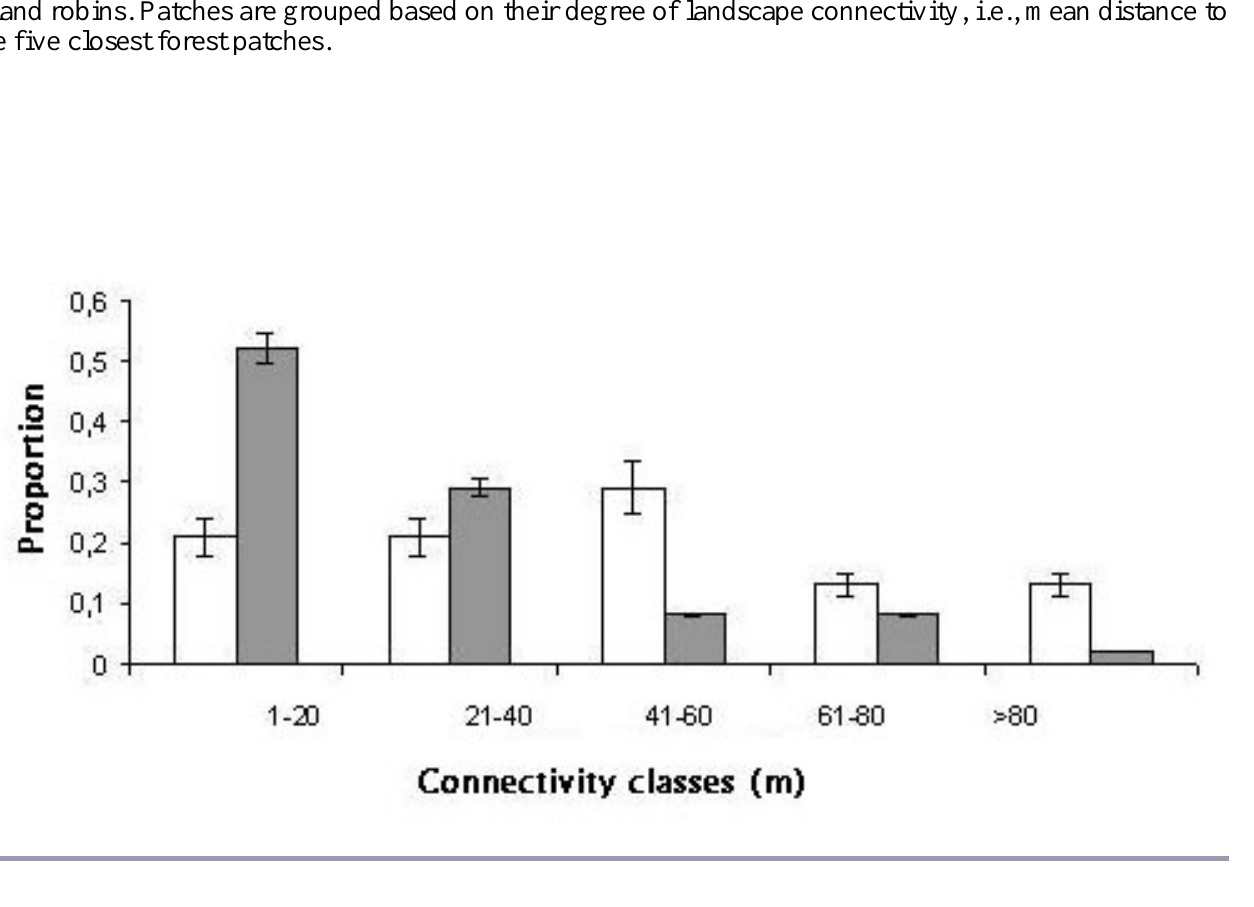
Fig. 3 . Observed (dark) vs. expected (white) use of available forest patches by dispersing juvenile North Island robins. Patches are grouped based on their degree of landscape connectivity, i.e., mean distance to the five closest forest